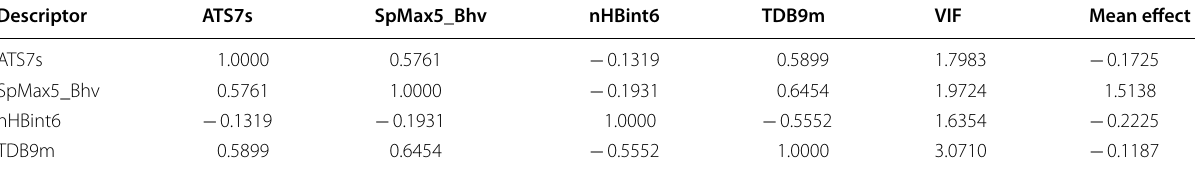
Table 8 Correlation statistics of the model